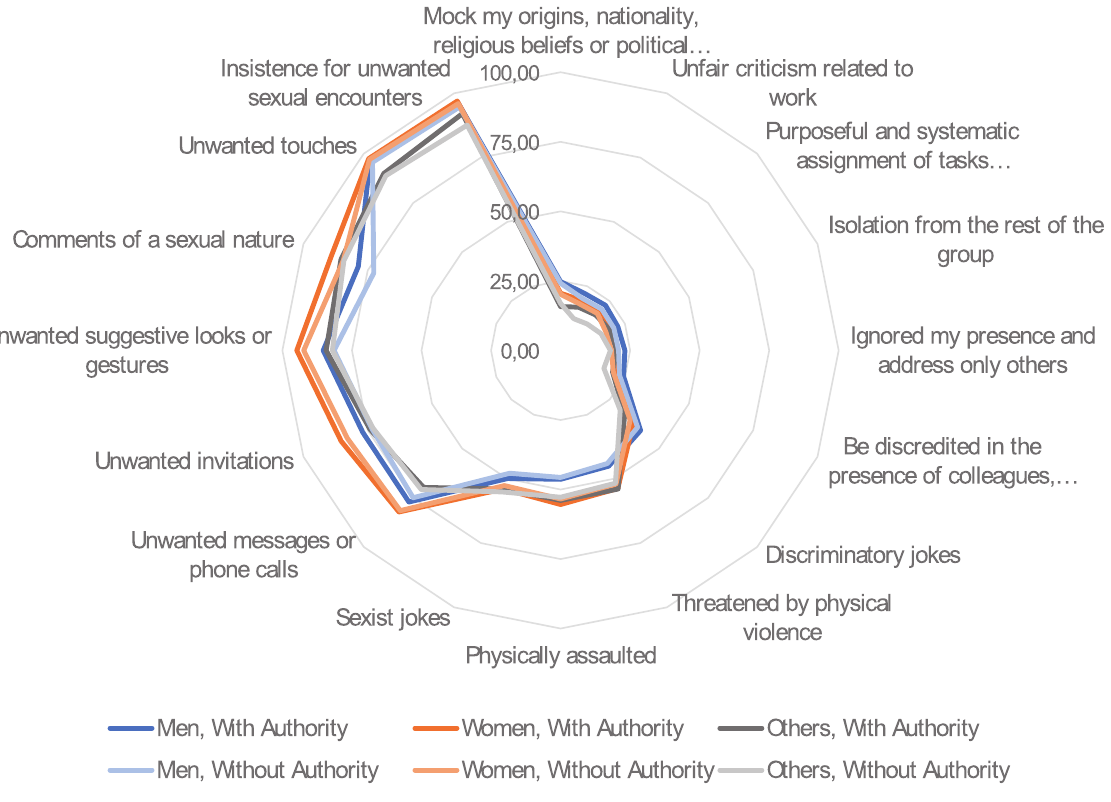
χ 2 (2, 6051) = 1.67, p = 0.43, V=0.17). And,